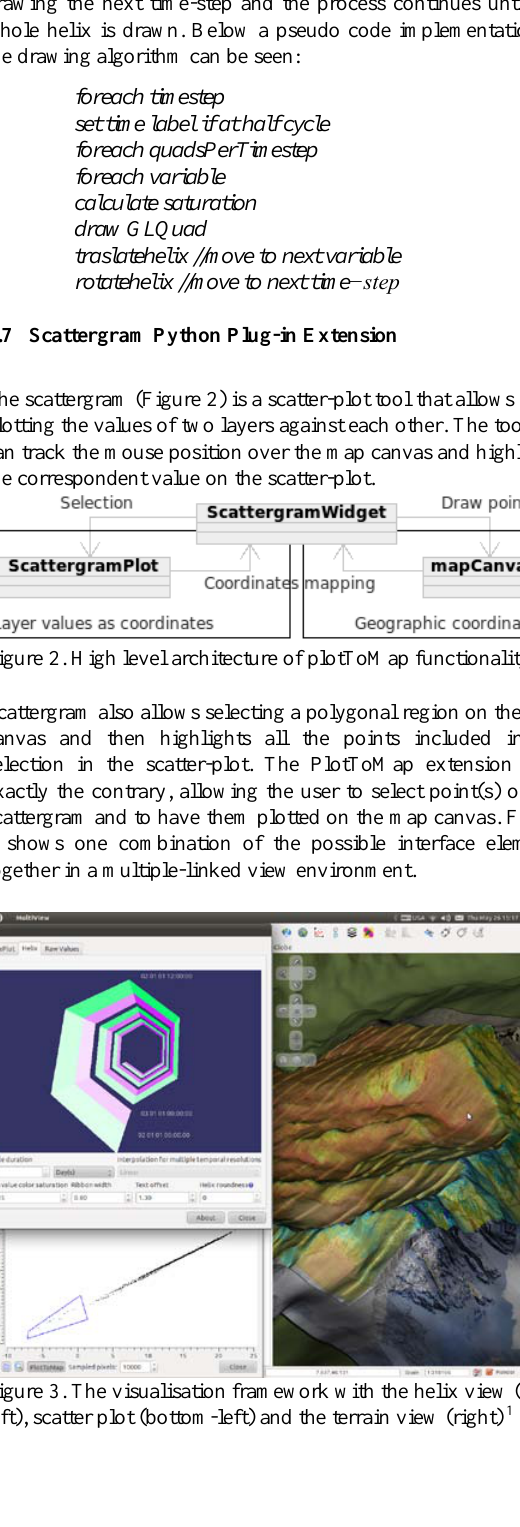
are available at